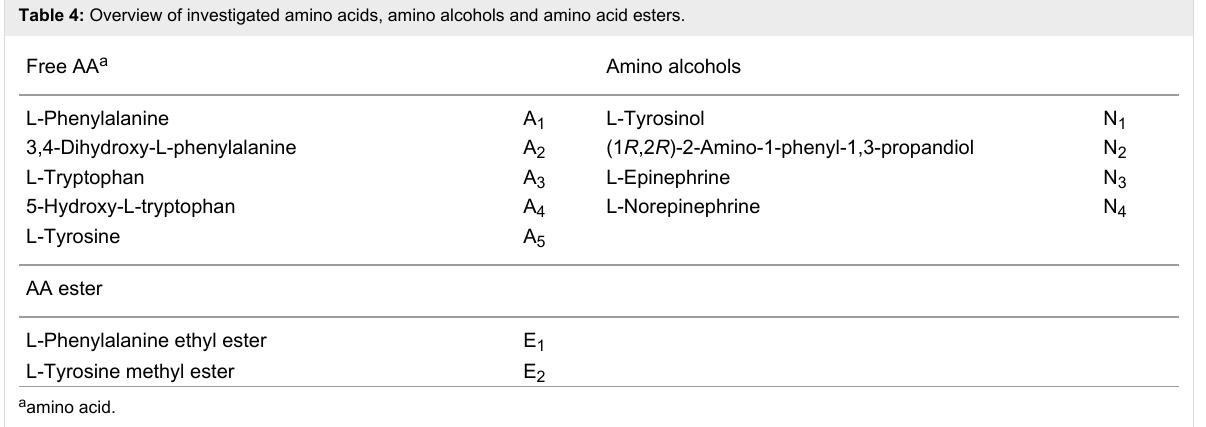
The presence of four decamethylene lateral chains in the struc- ture of C favored the arrangement of guests on the upper aromatic cavity of C , and the remote position of labeled or unlabeled methyl groups enables the kinetic measurements of the corresponding quasi-diastereomeric complexes under the same experimental conditions (Equation 8 and Equation